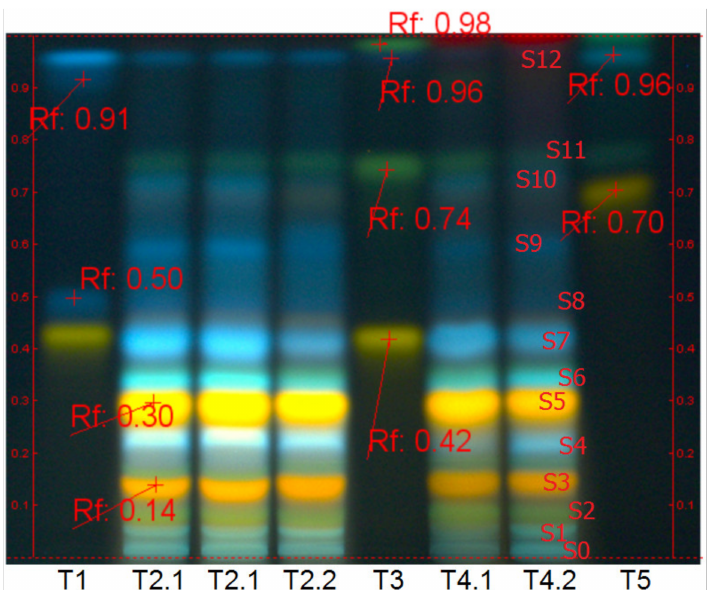
Figure 10. Chemical qualitative analysis (HPTLC method) ofcrude and hot, aqueous and ethanolic extracts from the aerial part of Anemone nemorosa L. ( herba et flores ). Solvent system—ethyl acetate: glacial acetic acid:formic acid:water, 100:12:12:26. Identification—NP/PEG No. 28, UV-366 nm.